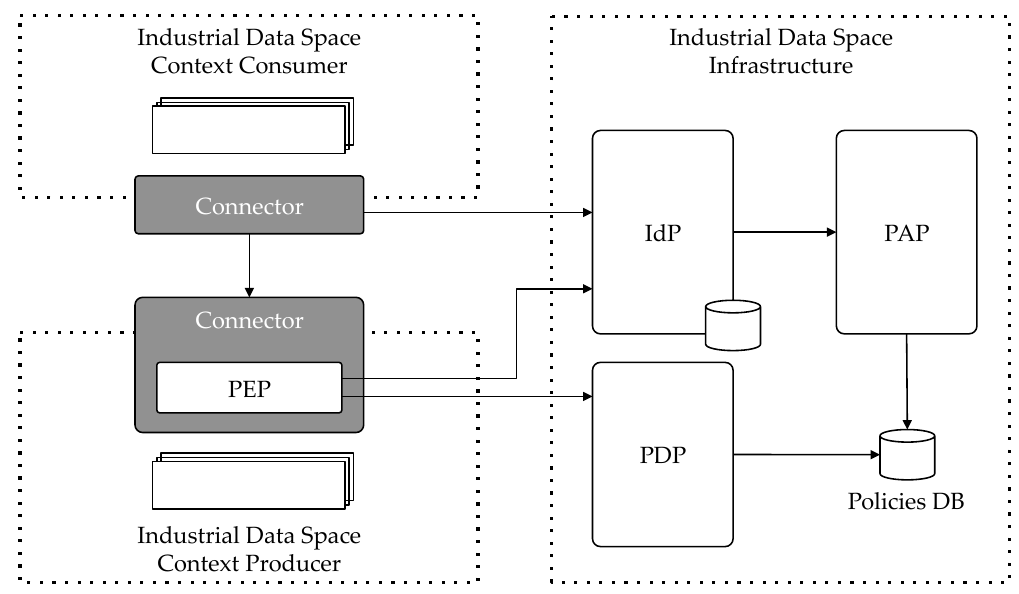
Figure 2. FIWARE IDS IAM